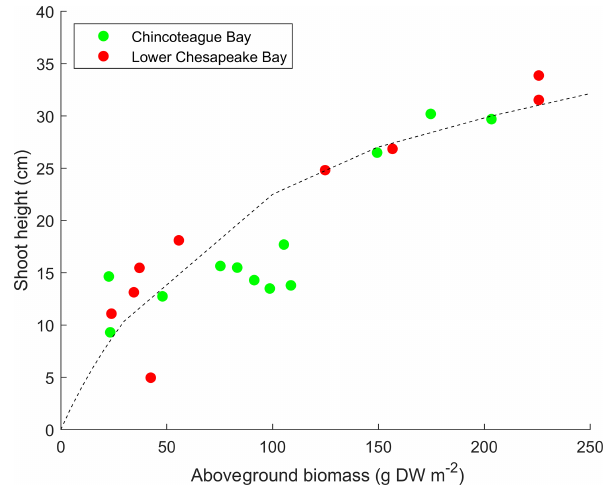
Figure 2. Empirical relationships between aboveground biomass and SAV shoot height for Zostera marina populations in polyha- line regions of Chesapeake Bay and Chincoteague Bay. DW refers to dry weight. Data are from Moore (2004) and Ganju et al. (2018).